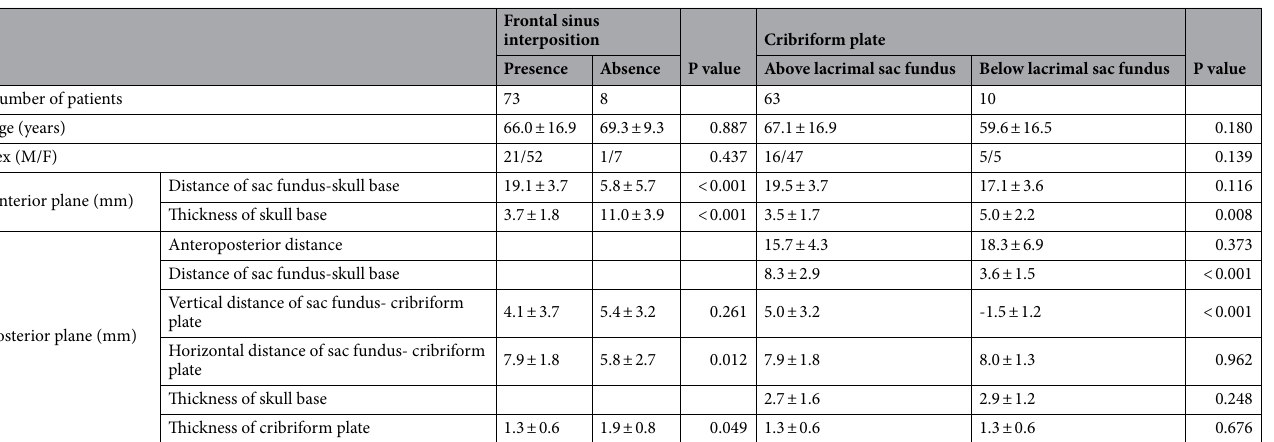
Table 3. Comparison of demographic data and measurement results between patients with and without frontal sinus interposition and between patients with and without the cribriform plate positioned above the level of the lacrimal sac fundus. M, male; F,